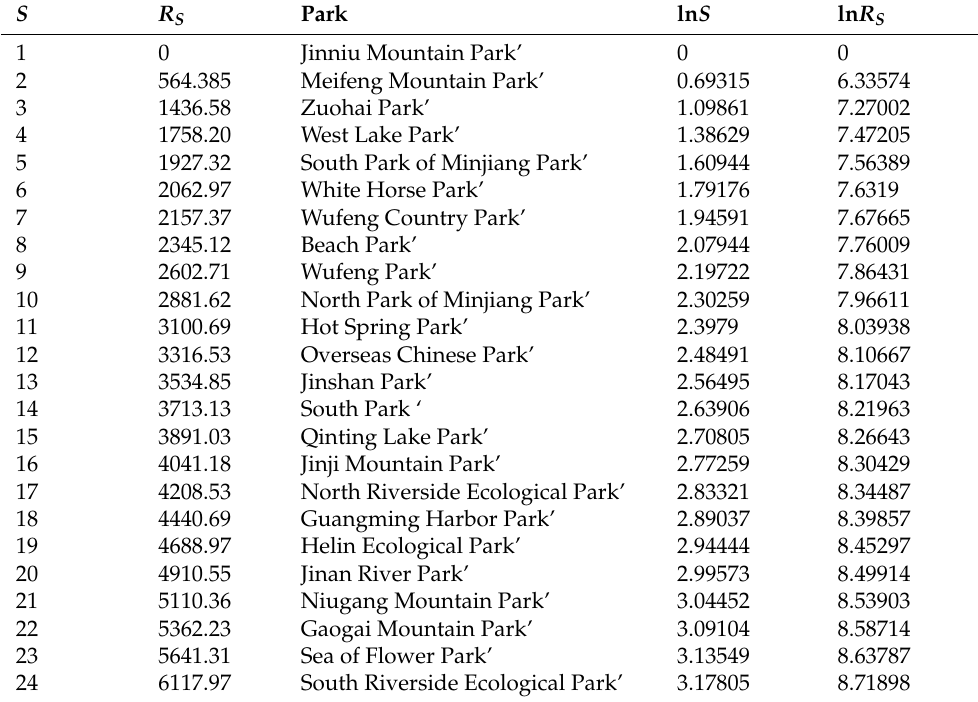
Table A3. Park system aggregation dimensions based on Jinniu Mountain Park.